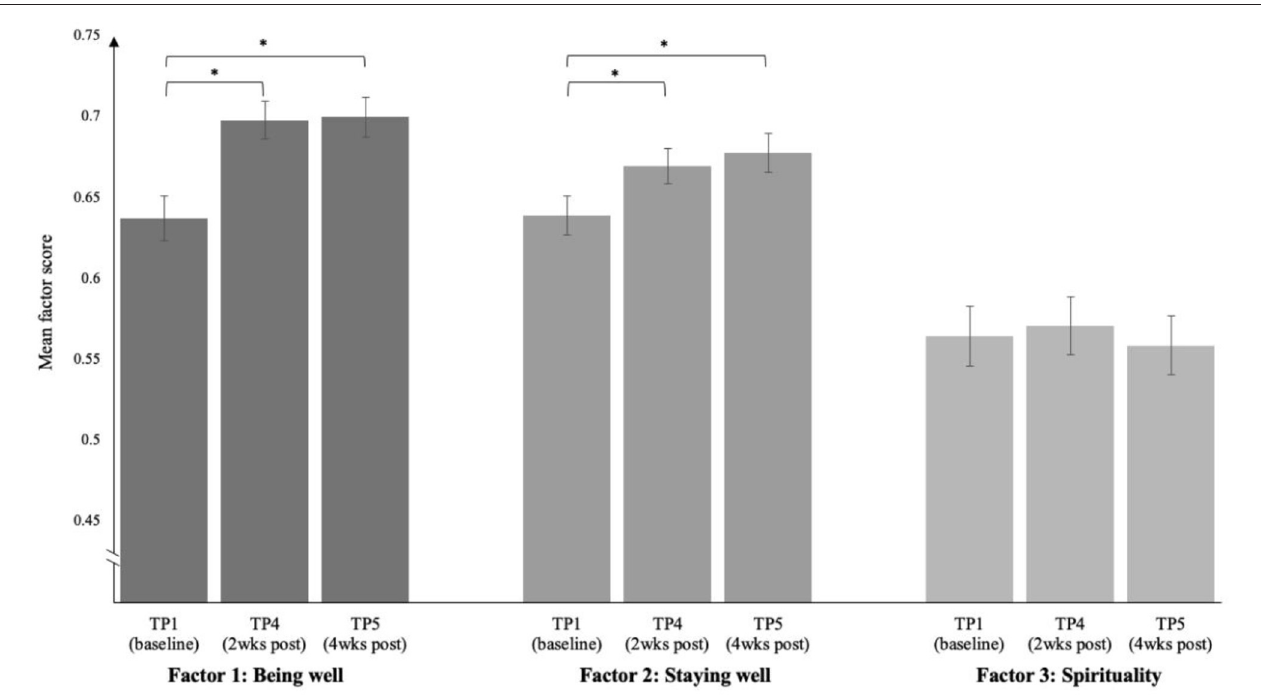
FIGURE 2 | Per factor: factor scores changing over time (baseline, 2 weeks, and 4 weeks post-experience, respectively). Scores are normalised to allow for comparison between factors. Asterisks indicate a significant change over the specifically indicated change within time points, p < 0.05.